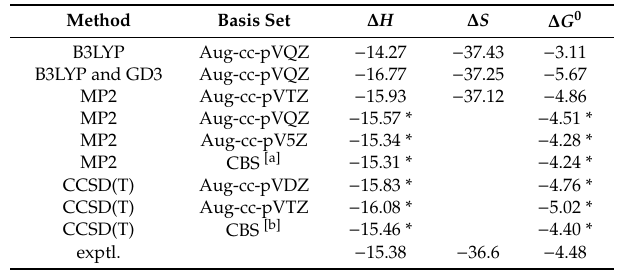
Table 2. The calculated values of the dimerization enthalpy (kcal / mol), entropy (cal / mol · K), and Gibbs energy (kcal / mol) of acetic acid at di ff erent computational levels. The results for the MP2 and CCSD(T) (coupled cluster with single, double and perturbative triple excitation) methods rely on MP2 / Aug-cc-pVTZ thermochemical calculation. Aug-cc-pVDZ: augmented